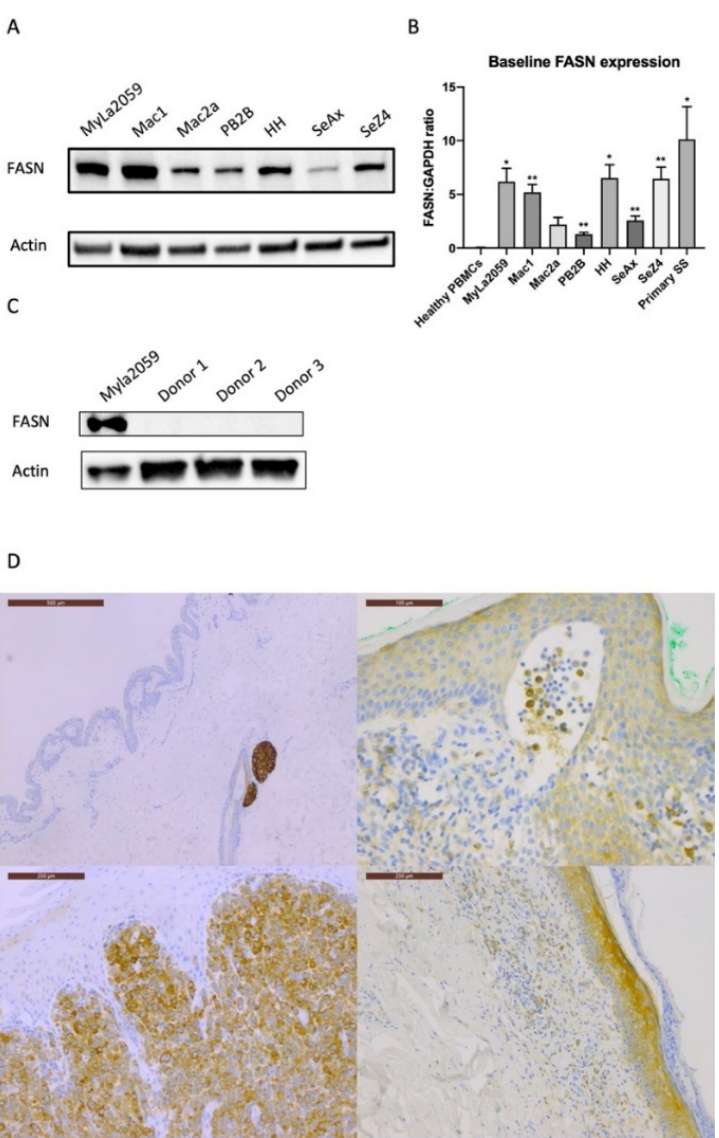
Figure 1. FASN expression in CTCL cell lines and biopsies. ( A ) Western blot and ( B ) qPCR showed increased levels of FASN expression in CTCL cell lines. ( C ) Protein expressions of FASN in PBMCs from three healthy donors were compared to FASN expression in MyLa2059. ( D ) Immunohisto- chemistry on skin biopsies verified the presence of FASN in MF patients (Figure 1D upper right, lower right, and left). Healthy skin revealed positivity only in skin adnexa (Figure 1D upper left). In upper right, positive tumour cells in a Pautrier’s microabscess are depicted. In the lower row, MF samples with strong and weak to moderate positivity are shown. Individual bars indicate image scale, thus upper left bar: 500 μ m, upper right bar: 100 μ m, and lower left and right bar: 200 μ m, respectively. Statical significance between the control (healthy PMBCs) and individual samples were tested with two-sided Student’s t test. Asterisks above each column in ( B ) indicate the signifi- cance of difference compared to the control (* p ≤ 0.05; ** p ≤ 0.01). We found a tendency for a higher expression of FASN with increasing clinical stage, but the number of cases enrolled in this study was too small to make any firm conclusions (Table 1).